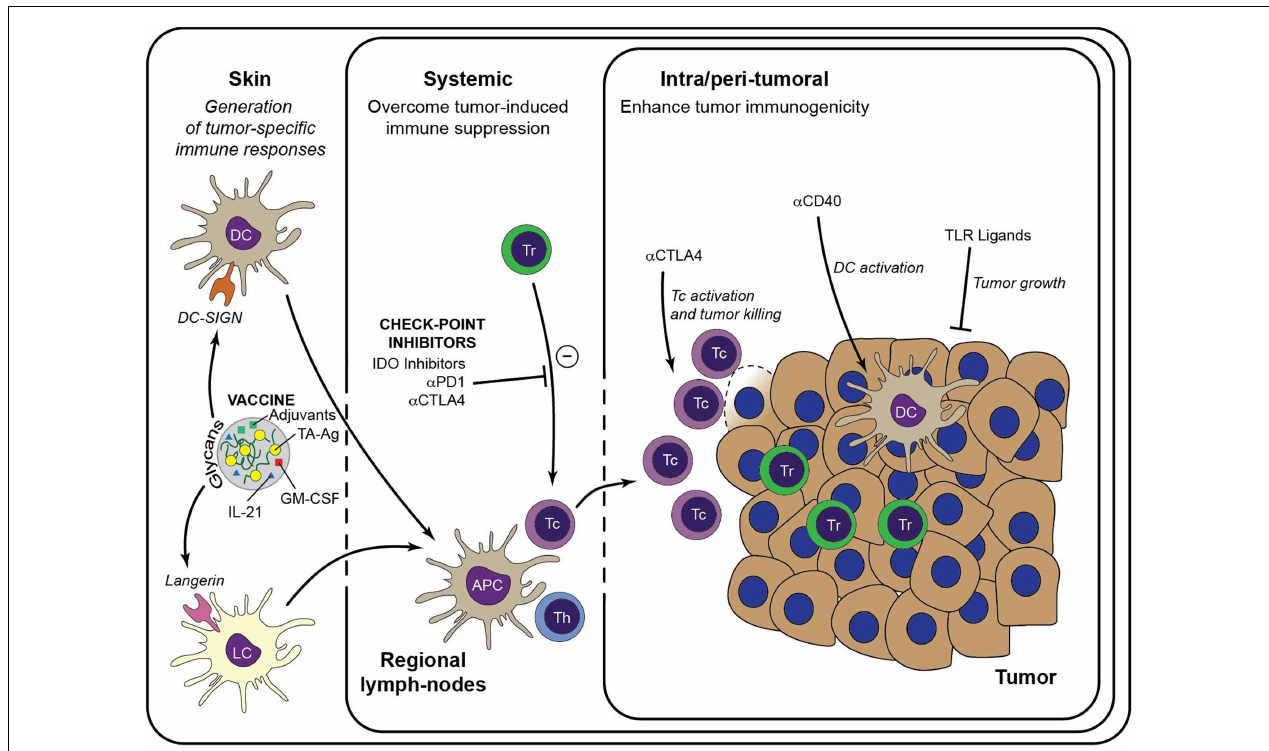
immunostimulators such as GM-CSF and IL-21 in the DC-targeting vaccine. Systemic or intra-tumoral administered check-point inhibitors, such as anti-PD-1 and anti-CTLA-4, release the break on the anti-tumor immune response by limiting the activity of suppressiveTreg and alleviate the priming and/or function ofTA-specific CTLs. Similarly, anti-tumor immunity may be enhanced by manipulation of the local micromilieu via administration of DC activating antibodies (e.g., anti-CD40) or ofTLR ligands that act directly on the tumor cells. It is anticipated that these strategies may enhance the efficacy of DC-targeted vaccination.Tc, cytotoxic CD8 + T cell;Th,T helper